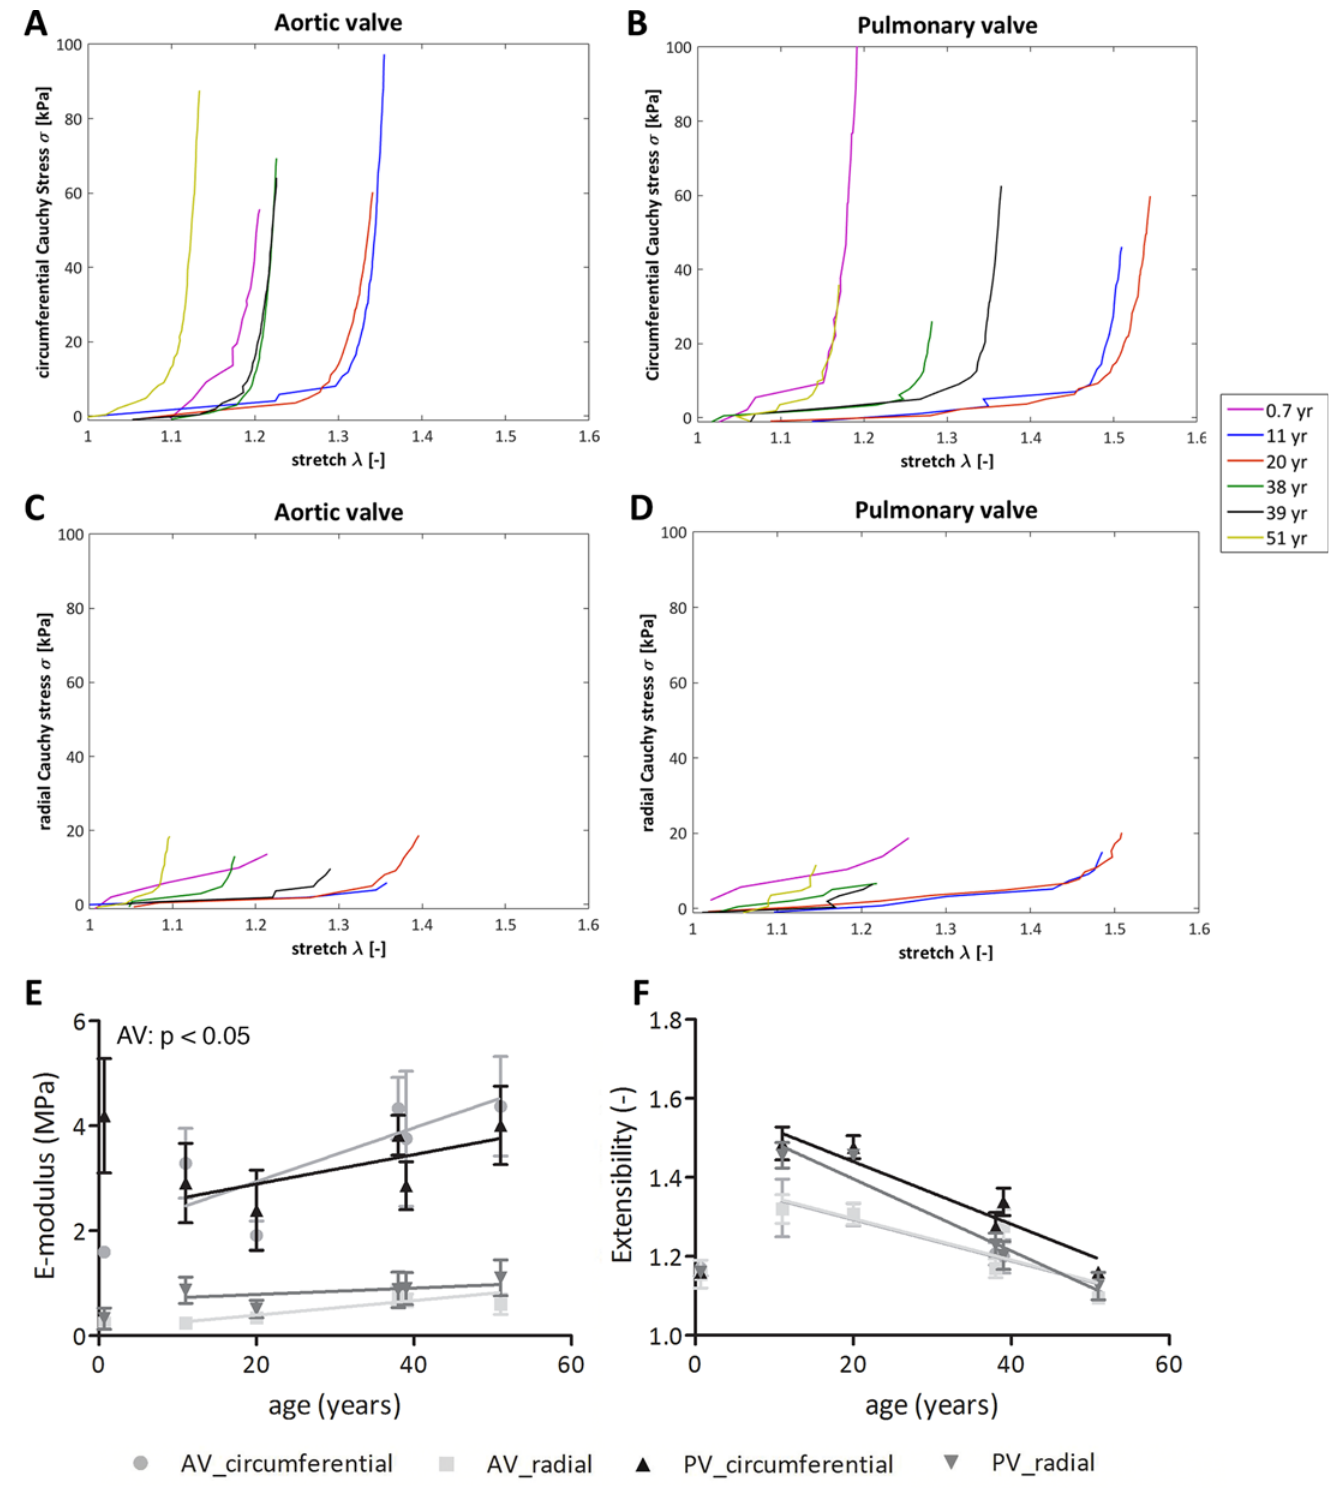
Fig 7. Averaged stress-strain curves, E-modulus at high strains, and extensibility obtained from biaxial tensile tests. Averaged stress-strain curves (A, B), E-modulus at high strains (C), and extensibility (D) obtained from biaxial tensile tests. The E-moduli (E) in both circumferential and radial direction increase with age in the aortic valve (p < 0.05). In the pulmonary valve the E-modulus does not change with age. The leaflets of the 11 and 20-year-old donors